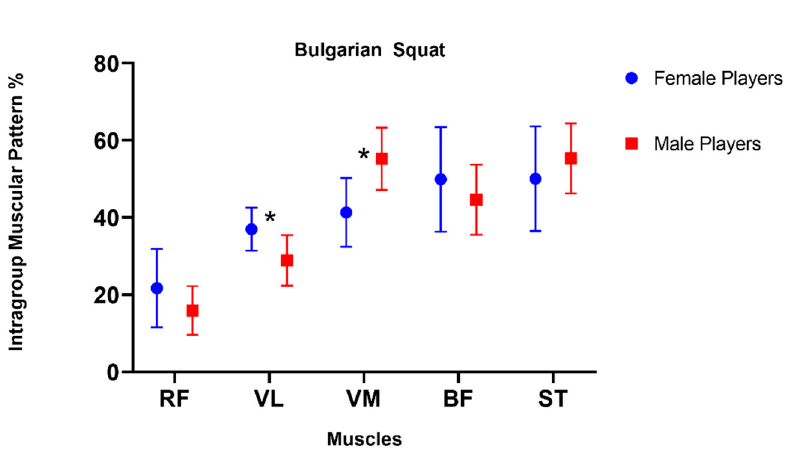
Figure 2. Intragroup muscular pattern (mean ± SD) in percentage. The intragroup muscular pat- tern expresses the activation of each muscle belly in relation to the total muscle (quadriceps and hamstrings). The asterisk (*) shows that there is a significant difference.